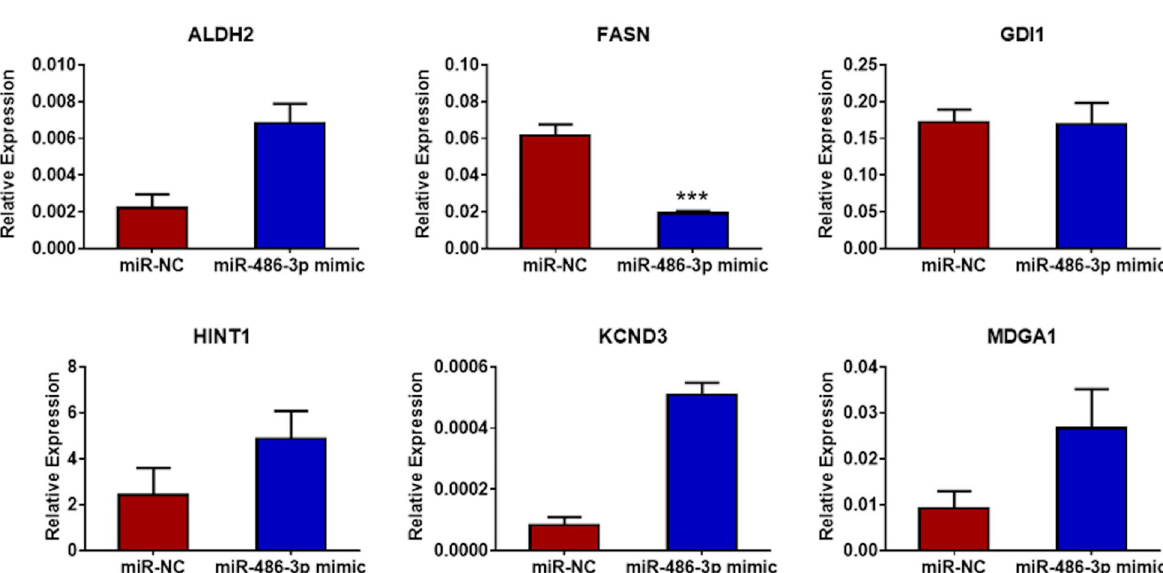
Figure 6. QRT-PCR analysis of potential targets of miR-486-3p in SW13 cells. MiR-486-3p mimic transfected SW13 cells revealed significantly downregulated levels of FASN ( p < 0.001) compared to miR-NC. The experiments were performed three